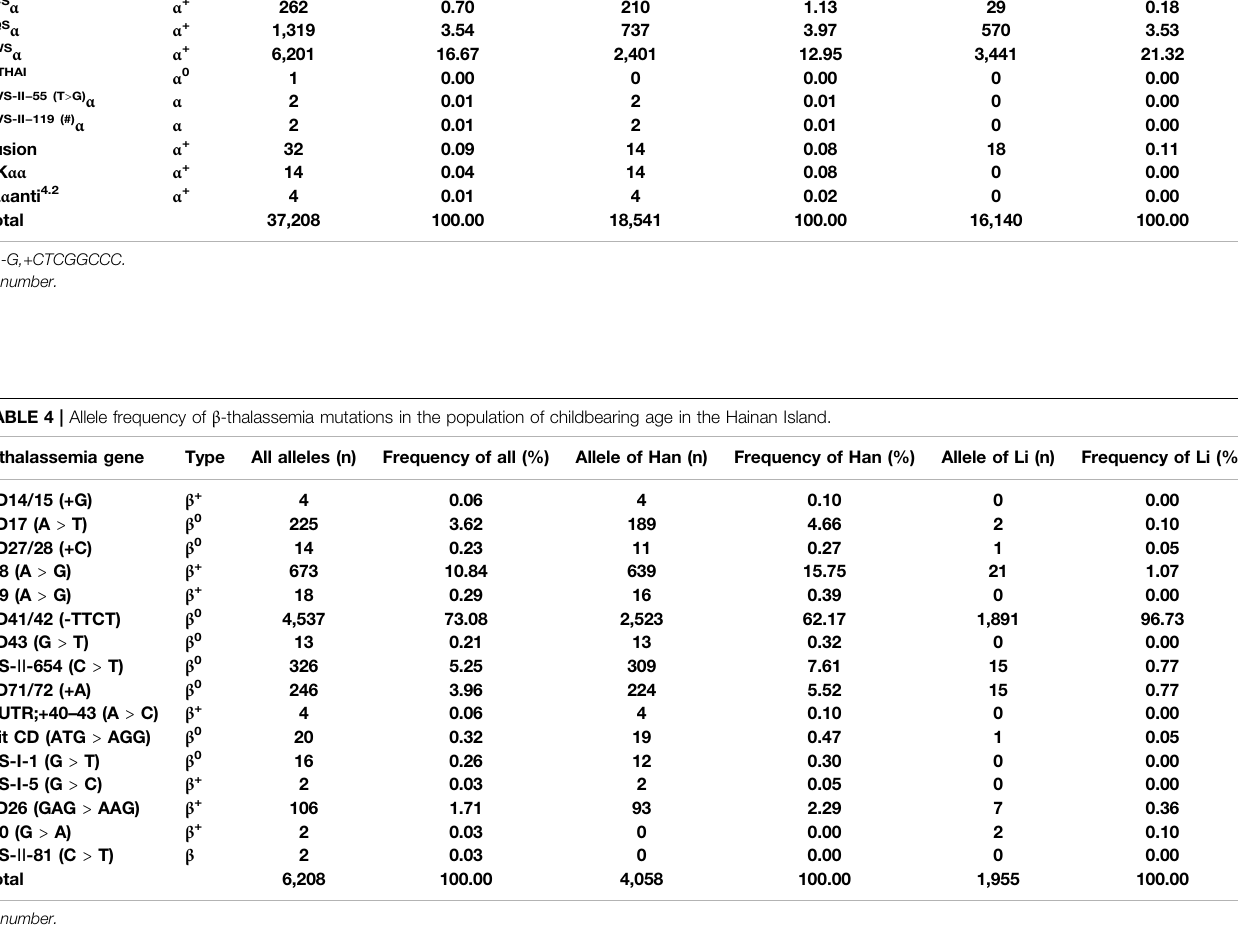
TABLE 5 | Prevalence of thalassemia in various ethnic groups in the population of childbearing age in the Hainan Island. Nationality